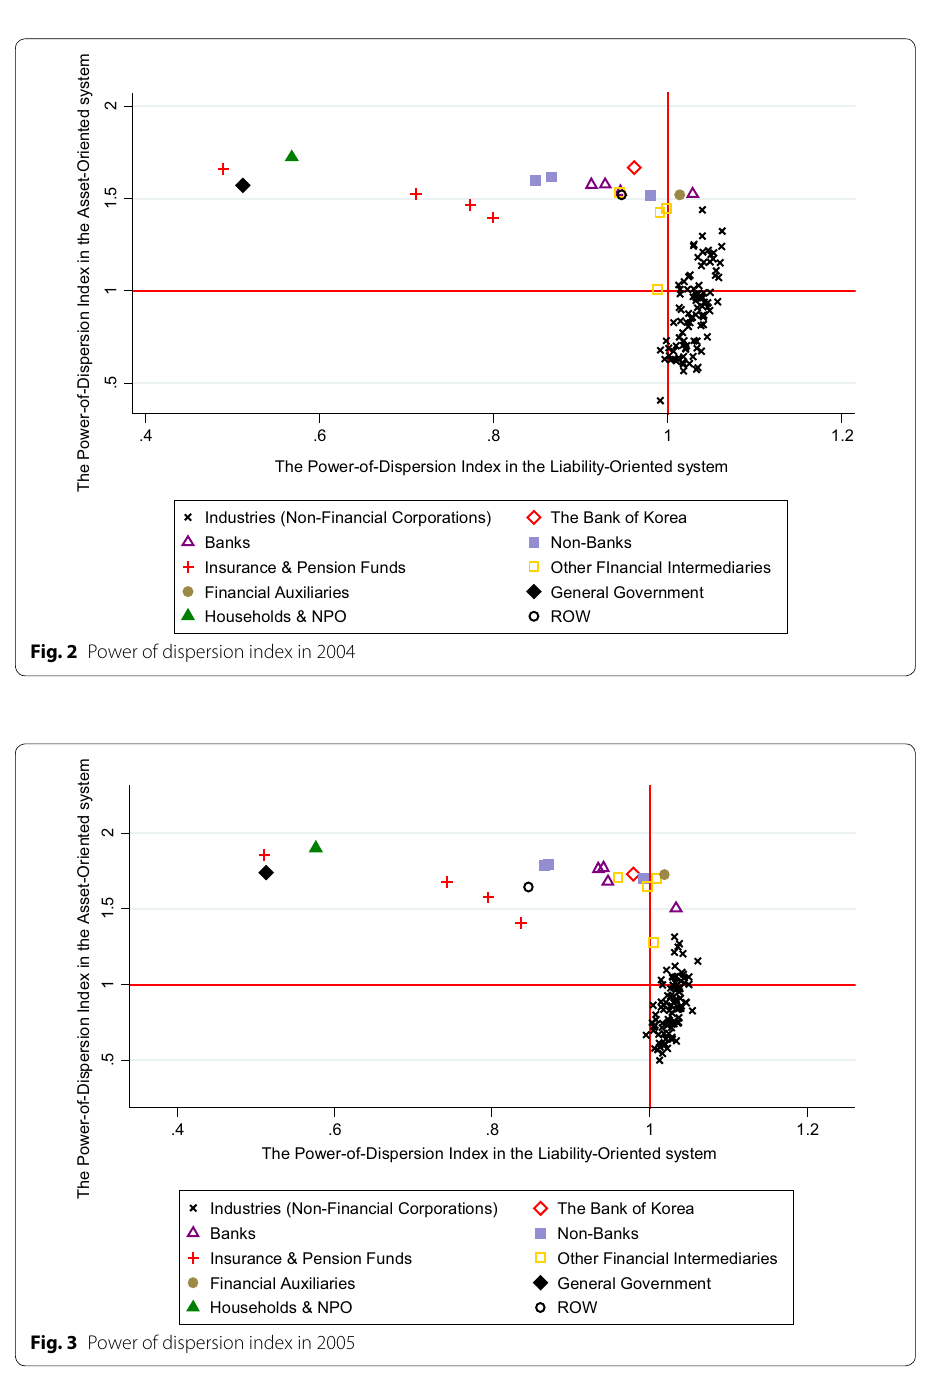
quadrant since they hold more power over liabilities and less power over assets. In Figs. 2 and 3, most institutional sectors other than nonfinancial corporations are located in the second quadrant. Financial auxiliaries and only a few financial institutions are included in the first quadrant. Most nonfinancial corporations are located in the fourth quadrant. However, 27 industries in 2004 and 22 industries in 2005 are sited in the first quadrant, indicating that both of their power indices are greater than 1.